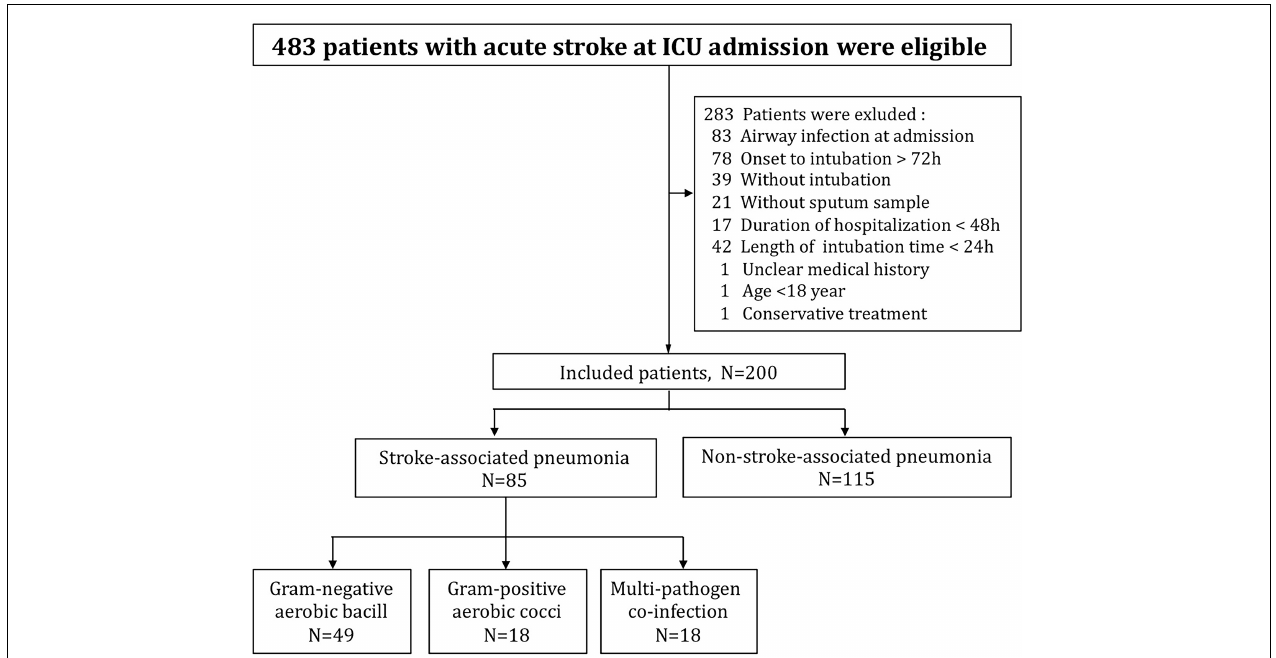
FIGURE 1 | Flow diagram of specific process of the trial, illustrating the number of patients in each step and each